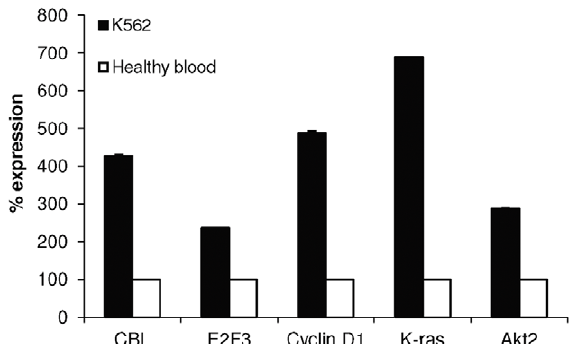
Figure 5. Expression of putative targets of the derugulated miRNAs. Expression of CBL, E2F3, cyclin D1, K-ras and Akt2 was analyzed by real-time PCR in K562 cells and in healthy blood samples . Shown is the percentage of miRNA expression normalized to GUSB